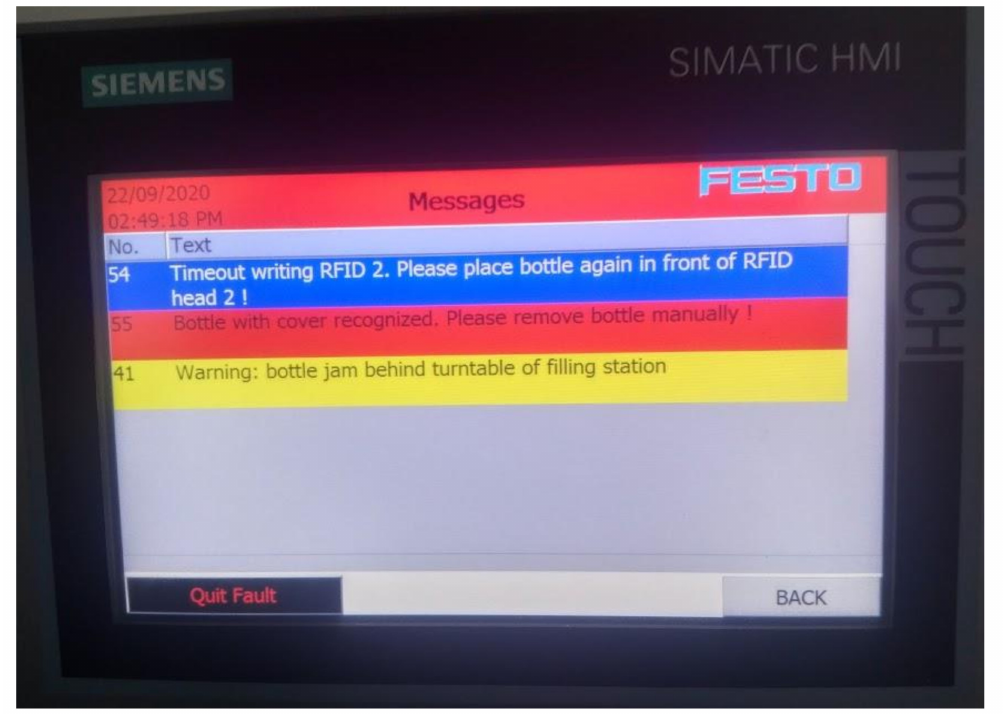
Figure 10. Error report on HMI